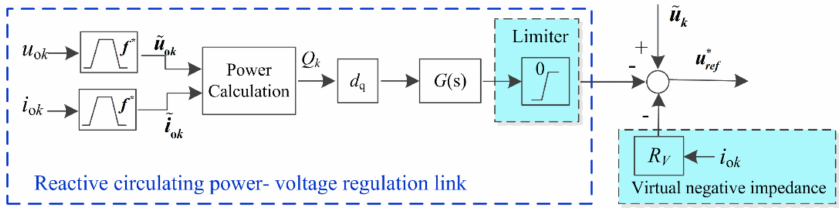
Figure 5. Improved bus voltage regulation method based on limiter link and virtual negative impedance.